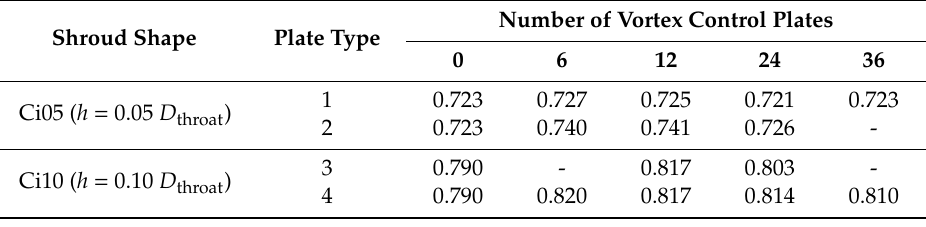
Table 4. The maximum values of C p ( = C p_max ) for every plate type.